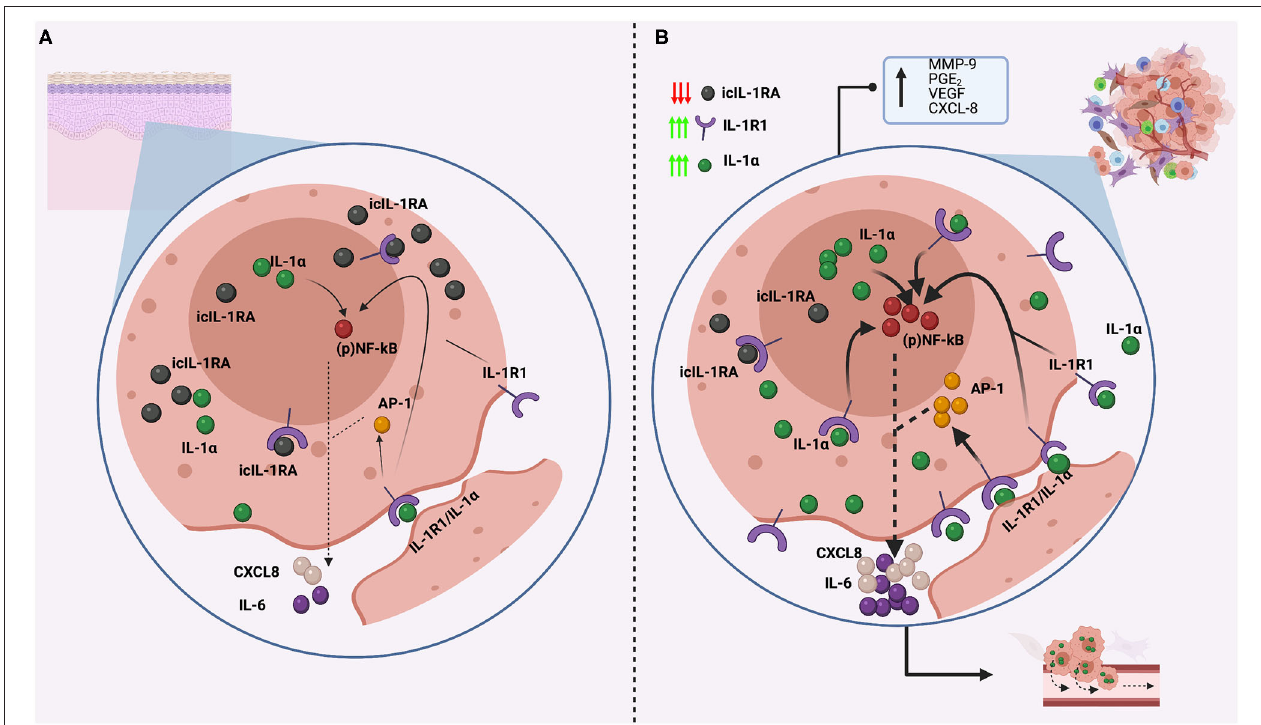
FIGURE 2 | Comparison of IL-1 α expression and regulation in normal head and neck keratinocytes (A) and in cancerous head and neck keratinocytes (B) . (A) Normal keratinocytes express low levels of IL-1 α , which is not normally secreted, and is regulated by icIL1RA, which is expressed in abundancy to efficiently counteract IL-1 α actions. This balance secure low NF-kB activity with low production of other inflammatory molecules, such as IL-6 and CXCL-8. (B) In cancerous head and neck keratinocytes, icIL-1RA expression is downregulated, whereas IL-1R1 and IL-1 α are constitutively upregulated, generating an imbalance in IL-1 regulation. IL-1 α can localize intracellularly and interact directly to the nucleus, can be attached to the cellular membrane (membrane IL-1 α ) or can be released to the extracellular space. Membrane and secreted IL-1 α can both bind to IL-1R1 receptors and activate NF- κ B and AP-1 transduction pathways, resulting in the release of IL-6 and CXCL8, which are considered oncogenic cytokines as are associated with tumor growth and metastasis. Also, intranuclear IL-1 α can interact directly with the nucleus inducing NF- κ B activation in a non-IL-1R1 dependent manner. This also results in the release of IL-6 and CXCL8, which are both overexpressed in HNSCC. This image was created with